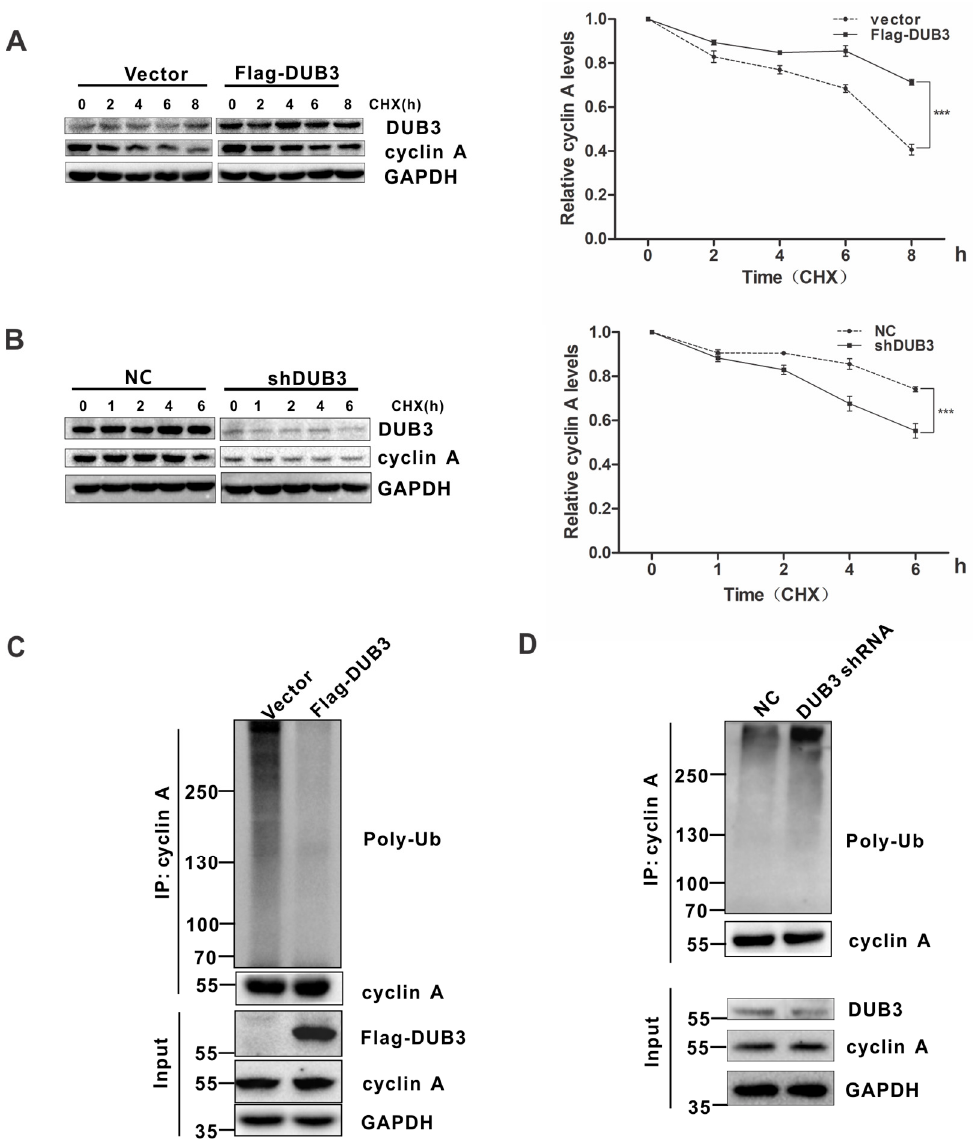
Figure 4. DUB3 stabilizes cyclin A through deubiquitination. ( A ) A549 cells transfected with the indicated plasmids were treated with 50 µ g · mL − 1 cycloheximide (CHX), collected at the indicated time points, and immunoblotted with anti-DUB3, anti-cyclin A, and anti-GAPDH antibodies. Quantification of the cyclin A levels relative to GAPDH expression is shown. Data represent the mean ( ± S.D.) of three independent experiments (*** p < 0.001). ( B ) A549 cells infected with the indicated lentiviral shRNAs were treated with 50 µ g · mL − 1 CHX and then collected at the indicated time points for Western blot analysis. Quantification of the cyclin A levels relative to GAPDH expression is shown. Data represent the mean ( ± S.D.) of three independent experiments (*** p < 0.001). ( C , D ) A549 cells either transfected with the indicated constructs ( C ) or infected with the indicated lentiviral shRNAs ( D ) were treated with MG132 (20 µ M) for 6 h before harvest. Cyclin A was immunoprecipitated with anti-cyclin A antibodies, and the immunoprecipitates were probed with anti-Ub or anti-cyclin A antibodies.